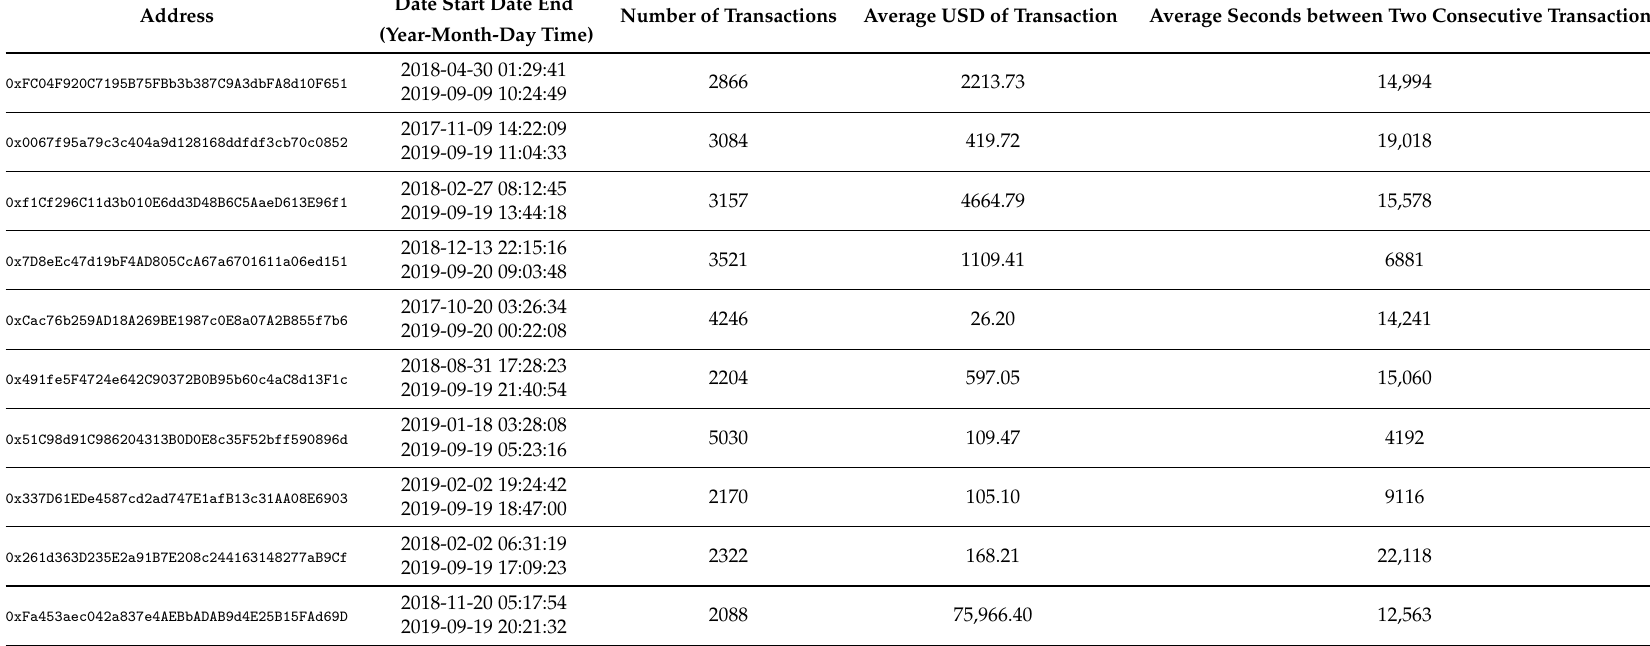
Table A1. Basic information about addresses in the